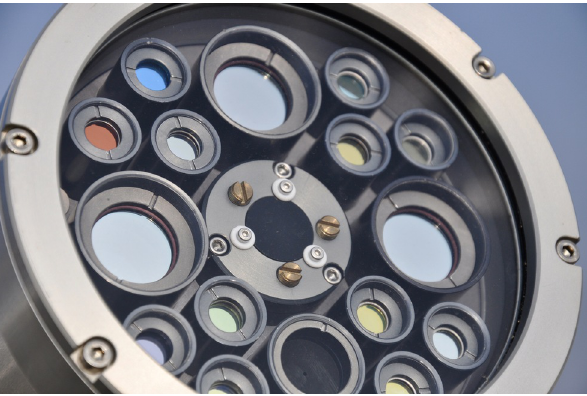
Figure 1. SSARA sensor head with 12 direct channels (smaller di- ameter tubes) and three polarized channels (larger diameter at the top, left, and right). The quadrant Sun tracker is in the center; below it is a finder for manual Sun